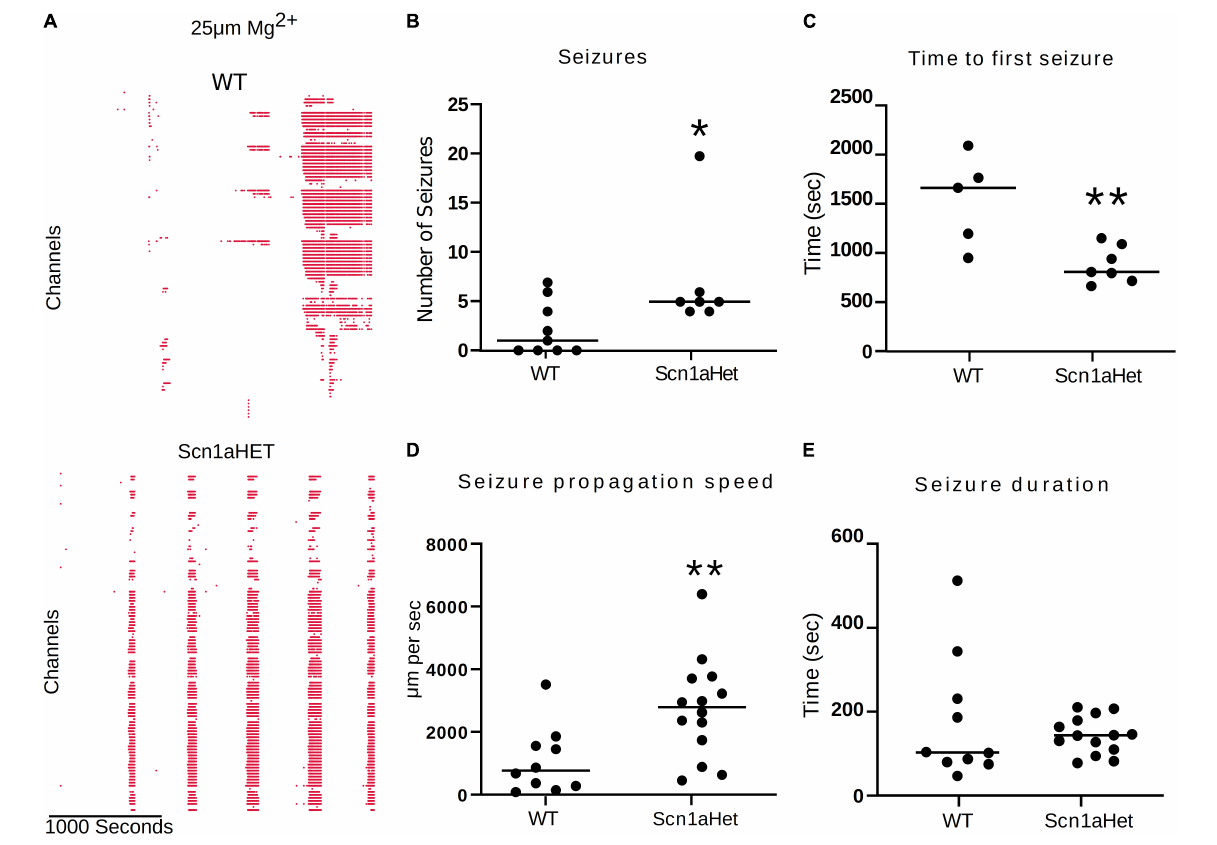
FIGURE 7 | Scn1aHet mice have an altered seizure pattern in the low Mg 2 + model. (A) Example raster plots from a control brain slice and a brain slice from Scn1aHet mice. (B) Scn1aHet mice have significantly more SLE than littermate controls (Mann–Whitney test, p = 0.04, n = 7–9 slices). (C) From the brain slices that displayed SLE, Scn1aHet demonstrated a significant increase in time to first seizure compared to littermate controls (unpaired t -test, p = 0.006, n = 5–7 slices). (D) SLE from the Scn1aHet propagate significantly faster than seizures in the littermate controls (Mann–Whitney test, p = 0.0059, n = 10–14 seizures from 5 to 7 slices). The first two seizure from the slices that had SLE were used in this analysis. (E) Seizure duration was not different between Scn1aHet and littermate controls (Mann–Whitney test, p = 0.66, n = 10–14 seizures from 5 to 7 slices). The first two seizures from the slices that had SLE were used in this analysis. * P < 0.05, ** P <